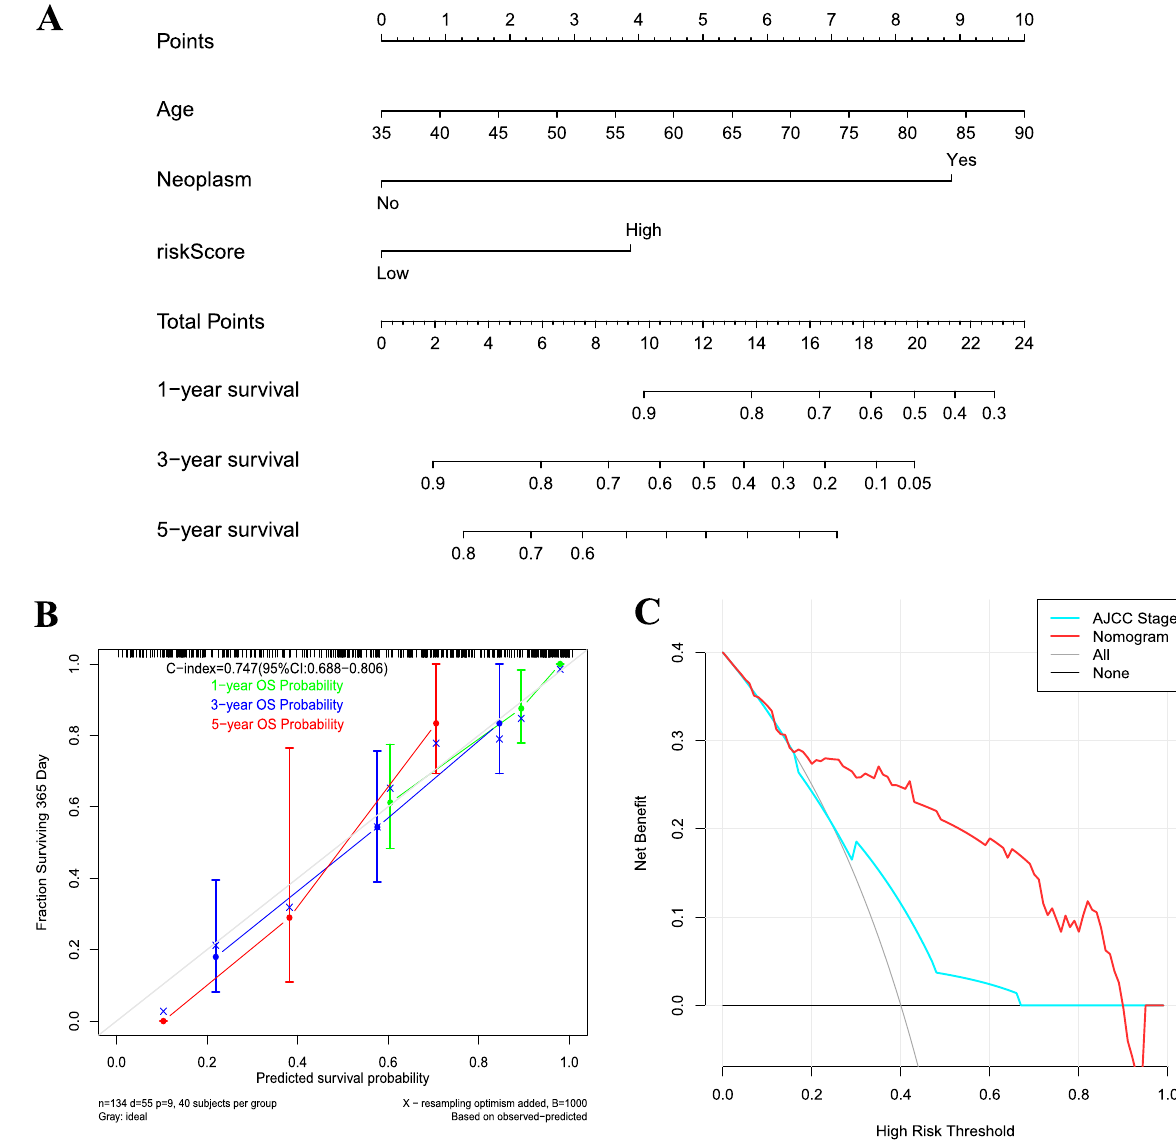
Figure 4. Nomogram construction based on the DNA repair gene signature. ( A ) Nomogram predicting overall survival probability for patients with GC; Assign the points of each variable of the patient by drawing a vertical line from that variable to the points scale, next, sum all the points, and draw a vertical line from the total points’ scale to the 1-, 3-, and 5-year OS to obtain the probability of death. ( B ) Calibration plots for the nomogram; Nomogram-predicted OS is plotted on the x-axis, and actual OS is plotted on the y-axis. A plot along the 45° line would present a perfect calibration model in which the predicted probabilities are identical to the actual outcomes. ( C ) decision curve analyses comparing nomogram and AJCC stage; the net benefit was plotted versus the threshold